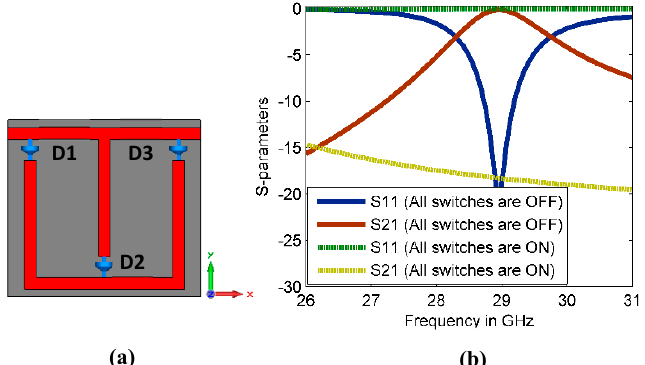
Figure 3. ( a ) Reconfigurable MM structure and ( b ) S-parameter results of the reconfigurable CSR structure.